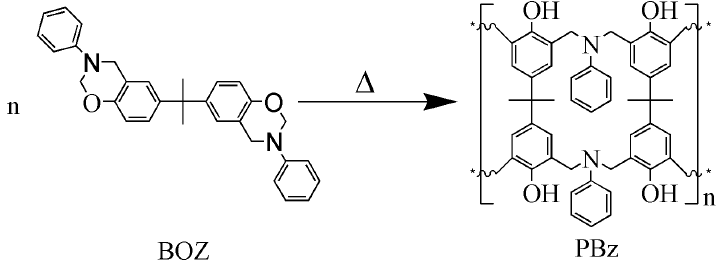
Figure 2. Curing mechanism of PBz.